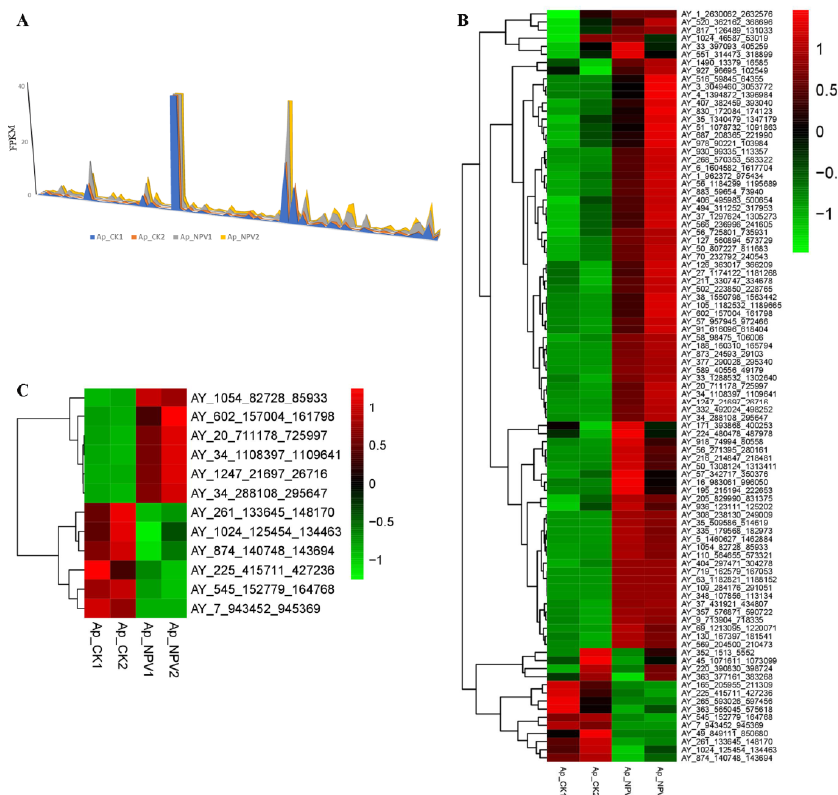
Figure 4. Expression of LTR-retrotransposons in ApNPV-infected A . pernyi larval midgut and uninfected control samples. ( A ) RNA sequence data from ApNPV-infected A . pernyi larval midgut and uninfected controls [3] were aligned using TopHat and transcripts were constructed using Cufflinks. The number of fragments per kilobase per million reads (FPKM) was plotted against the AyLTRs. ( B ) Heatmap of expression of LTR-retrotransposons in ApNPV-infected A . pernyi larval midgut samples and their uninfected controls after analysis of RNA sequence data. ( C ) Heatmap of differentially expressed LTR-retrotransposons (DELs) in ApNPV-infected A . pernyi larval midgut samples.